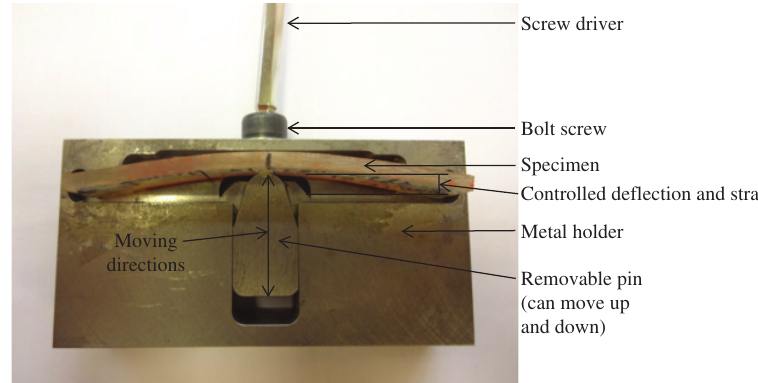
Figure 3 Photograph of metal